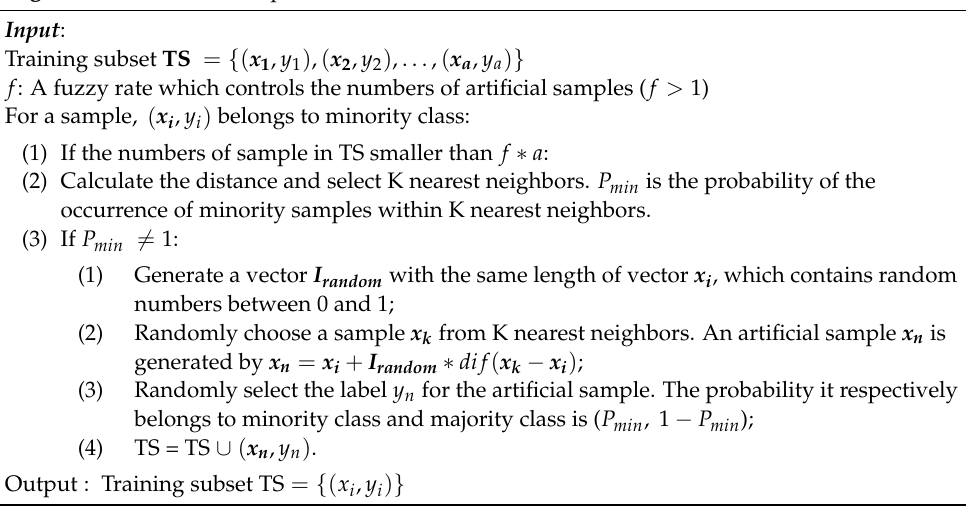
Algorithm 1 Artificial Sample